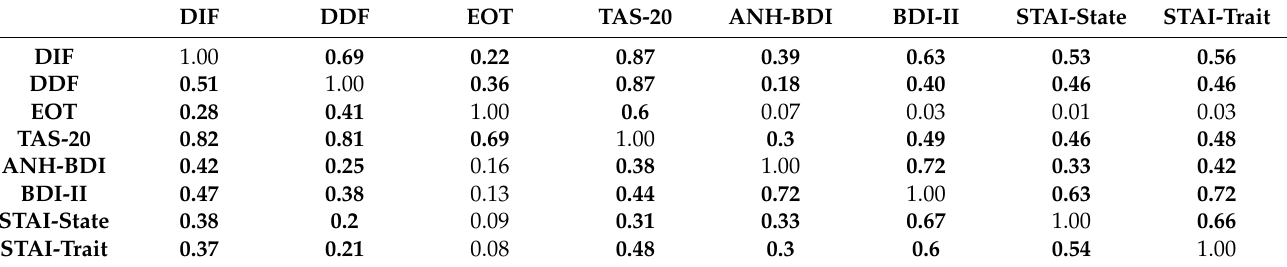
Table 2. Correlations between the rating scales (bottom: study group; below: control